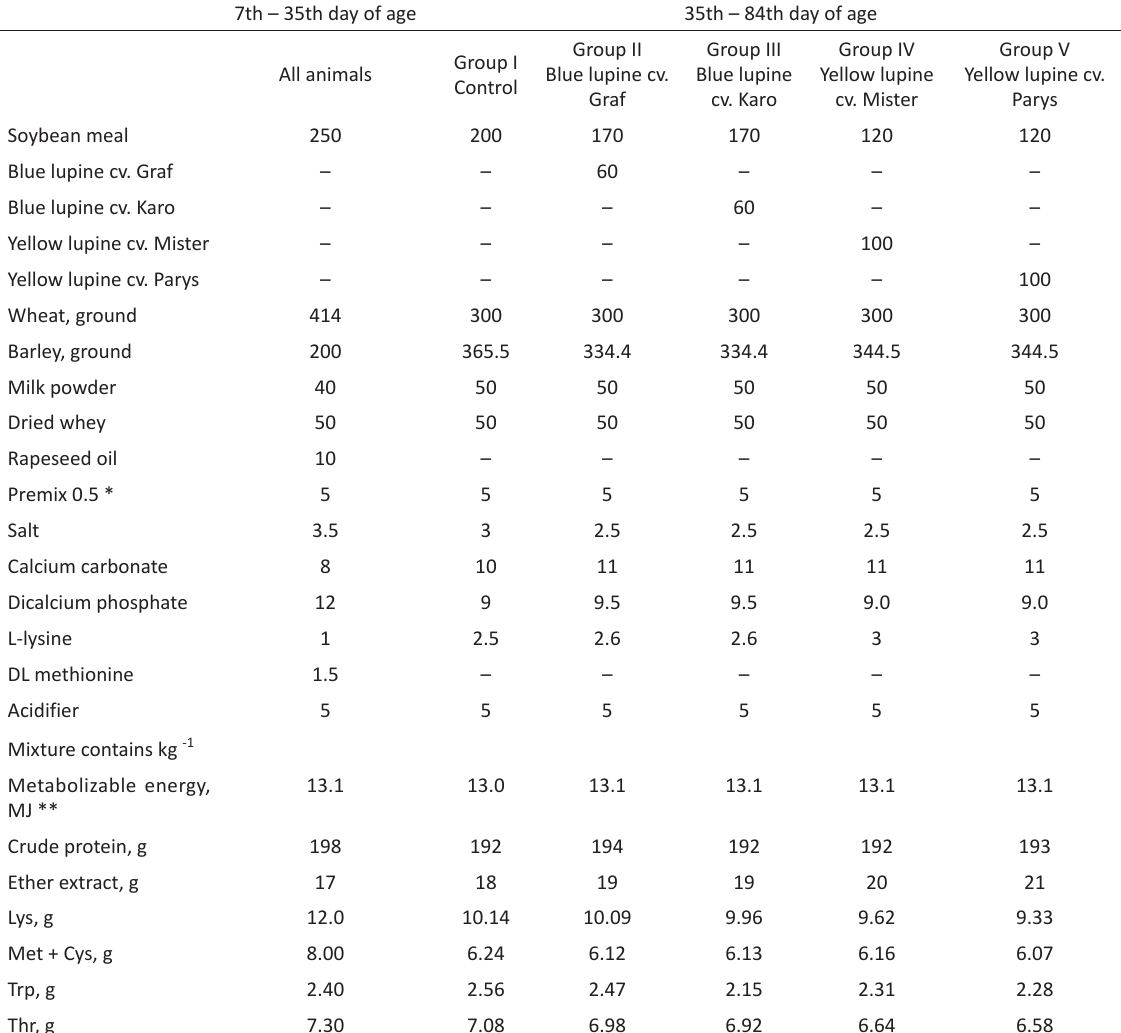
Table 2. Composition and nutrient contents of the diets for piglets (g kg -1 )